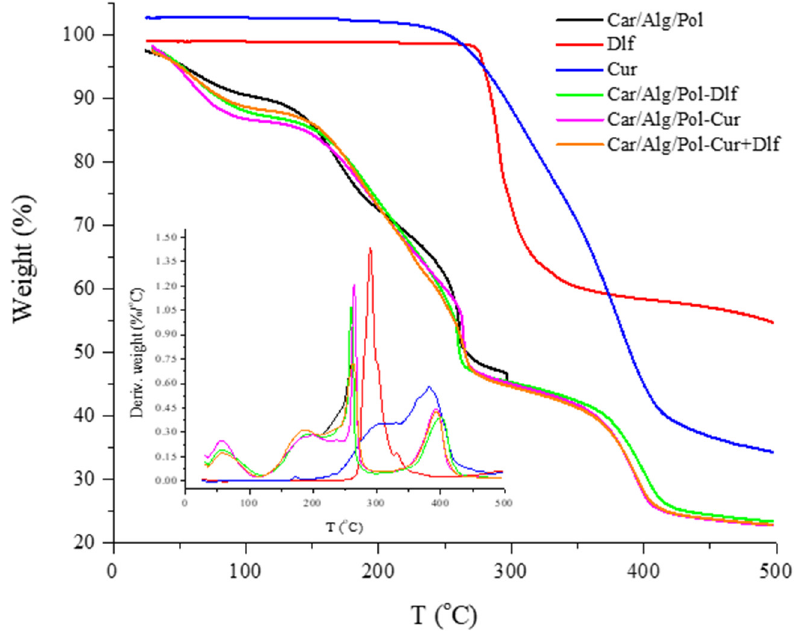
Figure 4. TGA and DTG curves of diclofenac, curcumin, and the Car/Alg/Pol, Car/Alg/Pol-Cur, Car/Alg/Pol-Dlf and Car/Alg/Pol-Cur+Dlf films.